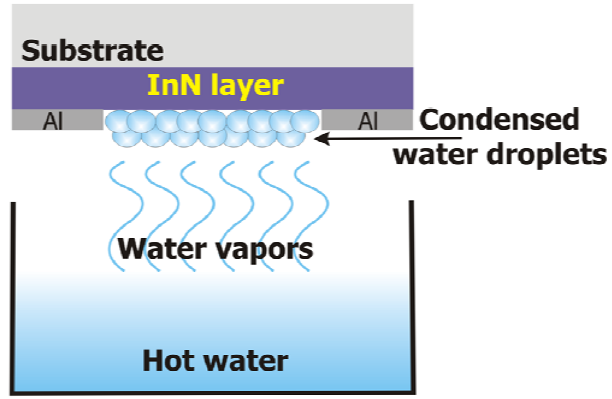
InN-based condensation sensors.